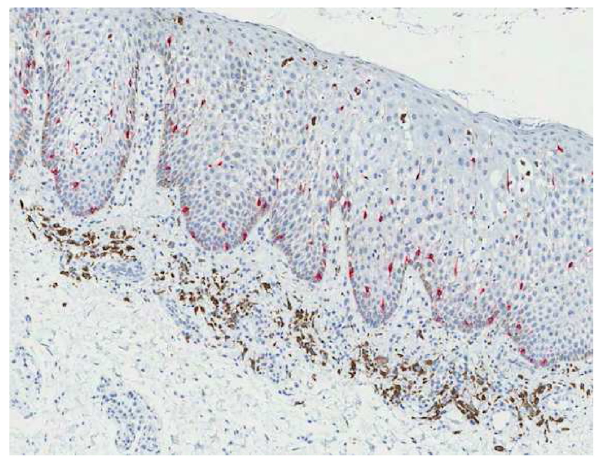
Figure 4. Follow-up clinical photograph. An eight-month- follow up visit revealed that the brown pigmentation had faded